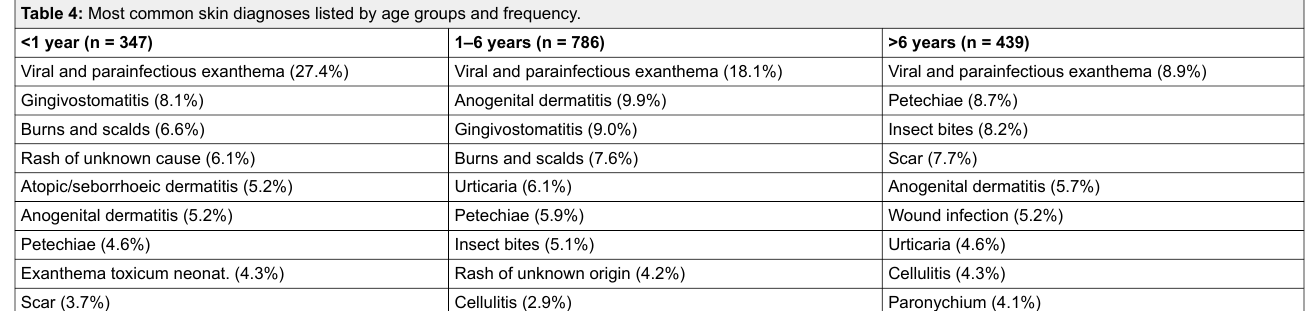
Table 4: Most common skin diagnoses listed by age groups and frequency. <1 year (n =